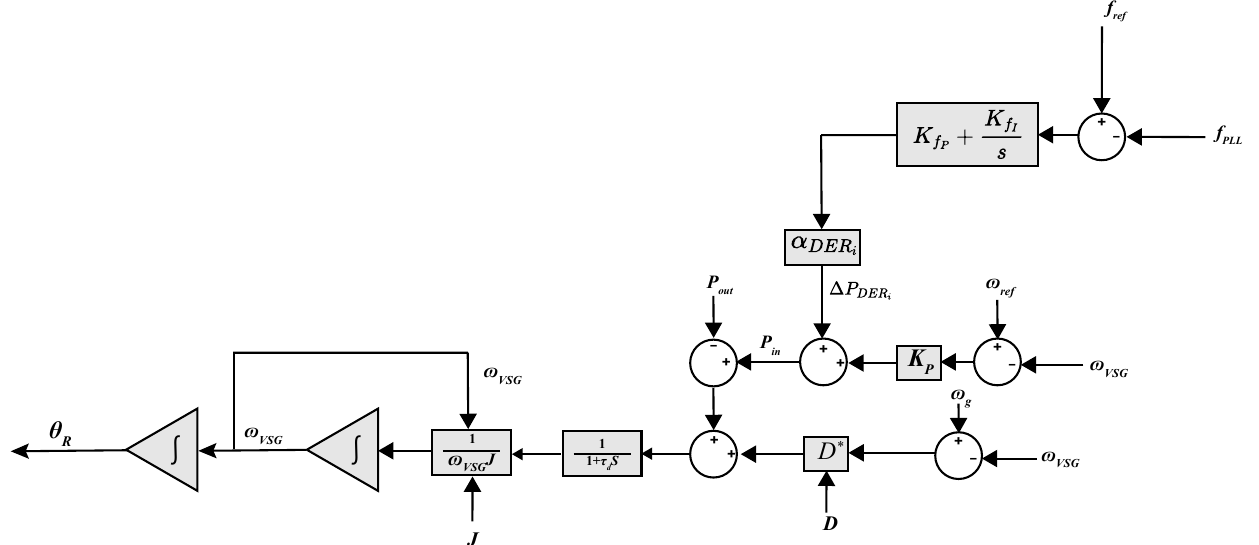
Figure 3. Virtual governor with active power frequency control